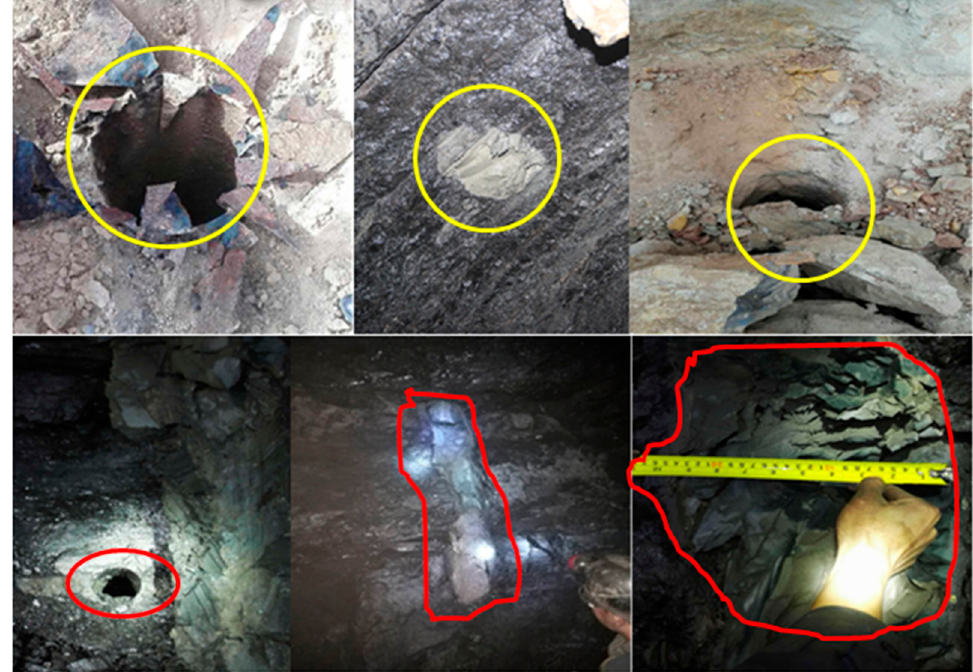
Figure 3. Records of underground exposure of Ma tan 31 oil well.